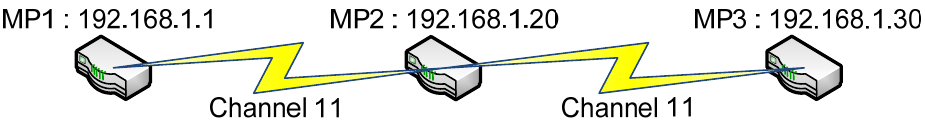
Figure 3. The 1-hop backhaul WMN connection (test 1).